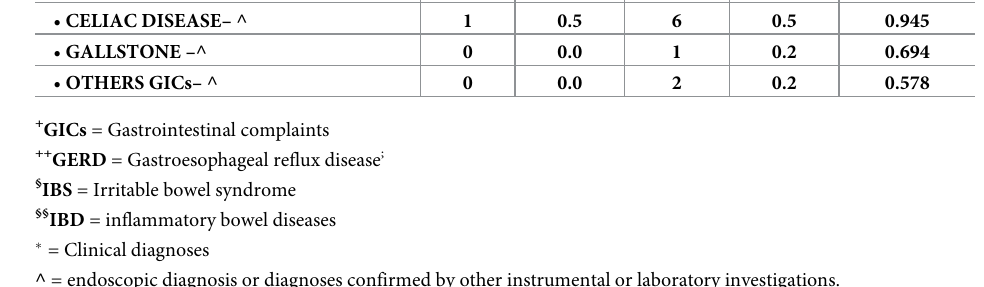
^^GERD = Gastroesophageal reflux disease ^^^IBS = Irritable bowel